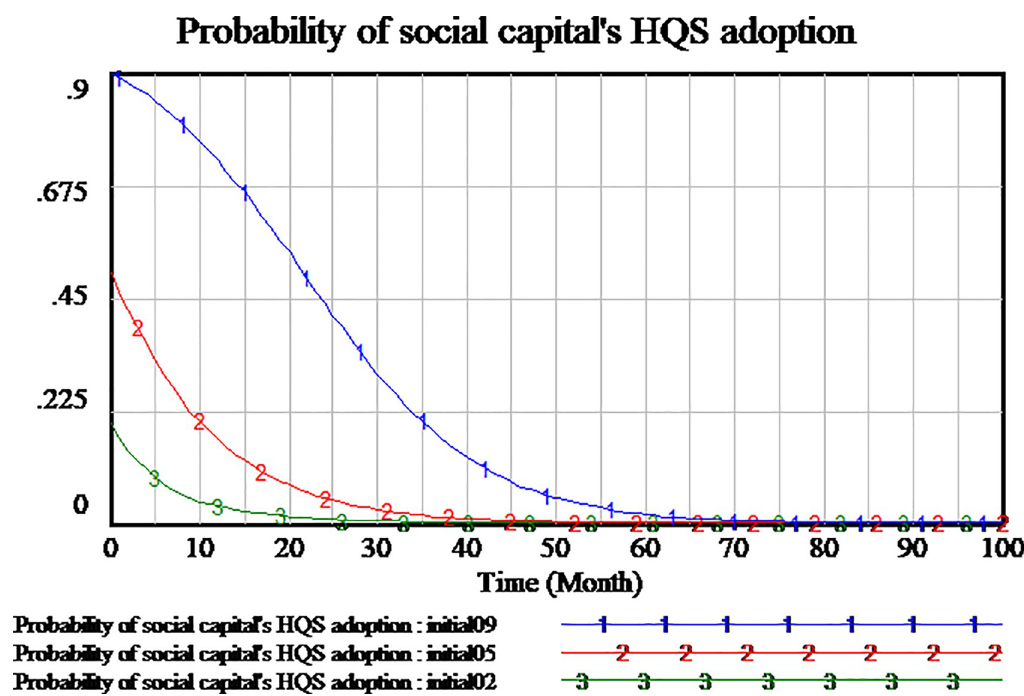
Fig 6. Impact of different initial strategies in social capital’s strategies